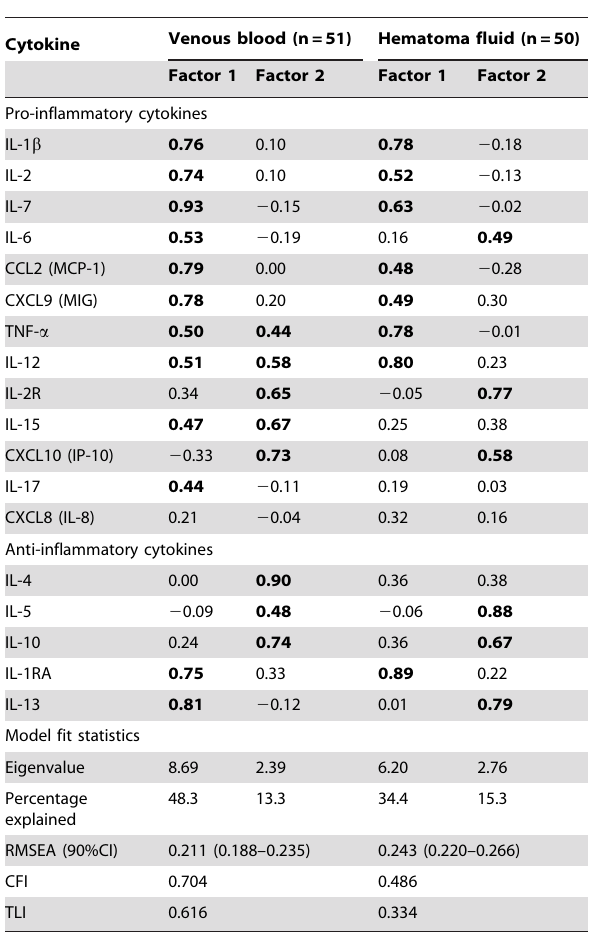
Table 2. Rotated standardized loadings from exploratory factor analysis.